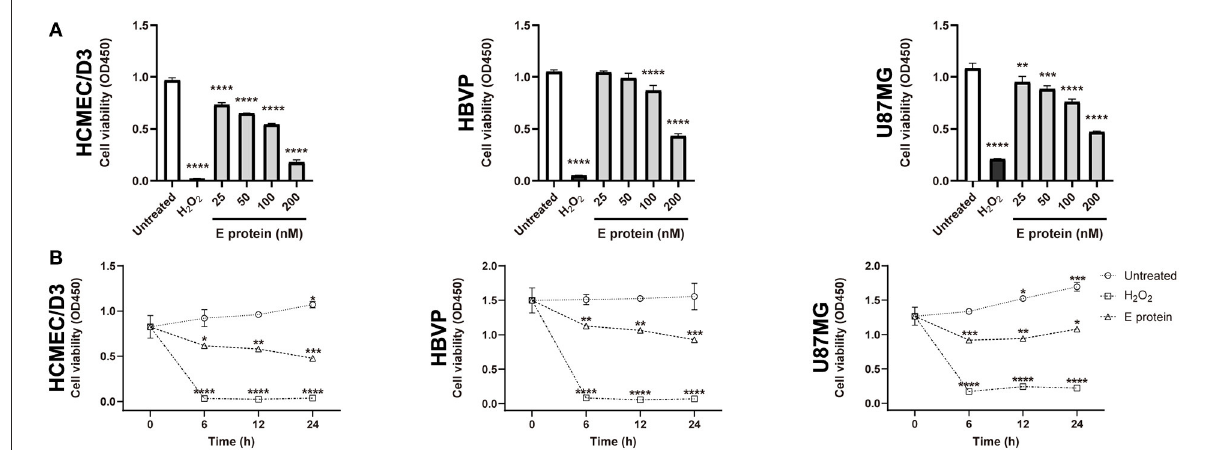
FIGURE1 SARS-CoV-2 envelope protein affects cell viability in vitro . (A) The viability of cells after exposure to a range of S2E protein concentrations for 12h. A CCK-8 assay was performed to assess cell viability. OD, optical density. (B) Time courses of the viability of HCMEC/D3, HBVP, and U87MG cells treated with 100nM S2E protein. The data are represented as the mean ± SD of three independent experiments. * p < 0.05, ** p < 0.01, *** p < 0.001, **** p < 0.0001.